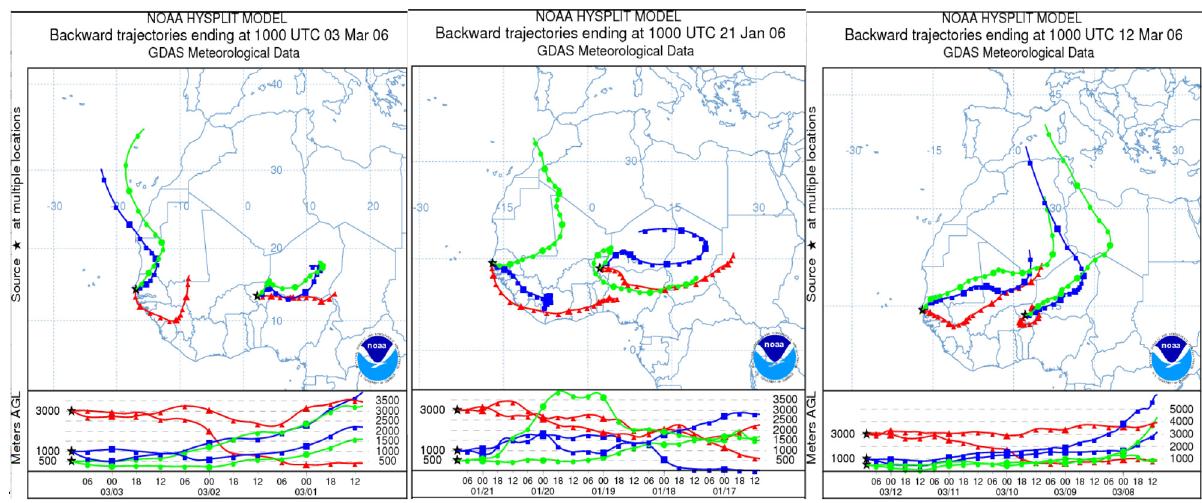
Figure 4. Backward trajectories traced by the NOAA Hybrid Single Particle Lagrangian Integrated Trajectory (HYSPLIT) model with endpoints in Dakar (black star on the coast) and Niamey (black star inland) for 12:00 UTC on the following days in 2006: ( left ) clean day 3 March; ( center ) mixture day 21 January and ( right ) dusty day 11 March. The time step is 6 h for 120 h (5 days). At the bottom of each map, back trajectories are represented for the following atmospheric heights: 500 m (green), 1000 m (blue) and 3000 m (red). These curves represent the height of the air mass during particle